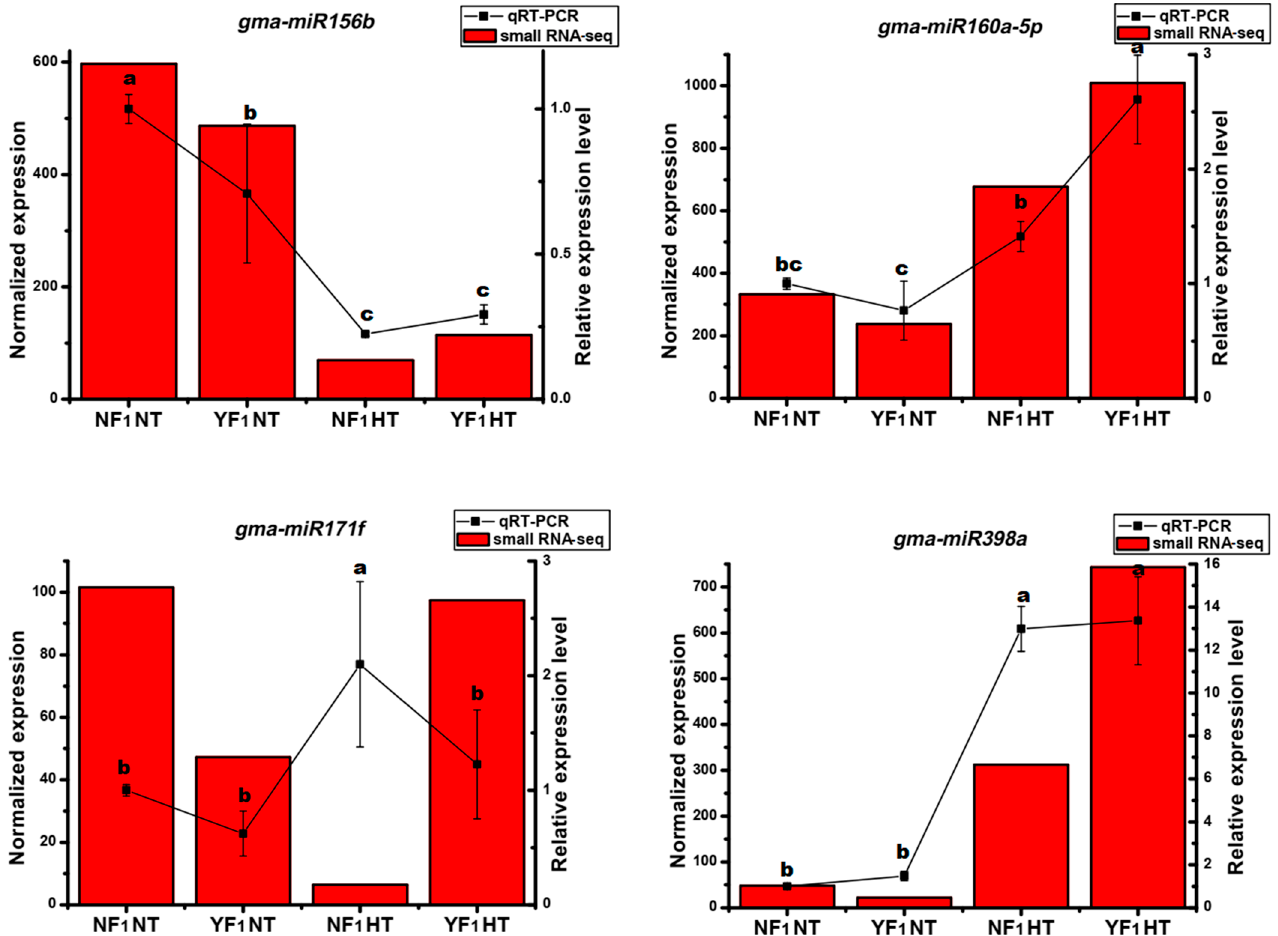
Figure 3. qRT-PCR analysis of HT-responsive conserved known miRNAs in the flower bud of soybean CMS-based F 1 under HT stress. Data are presented as means ± SD from three independent biological replicates. Values with a different letter indicate statistical differences (one-way ANOVA, Duncan’s test, p < 0.05). The left and right y -axes are the expression level scales for sRNA-seq and qRT-PCR analysis, respectively.